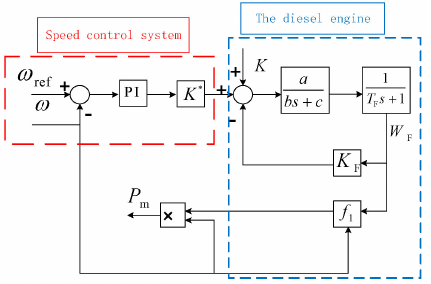
Figure 2. Speed control system and diesel generator model.